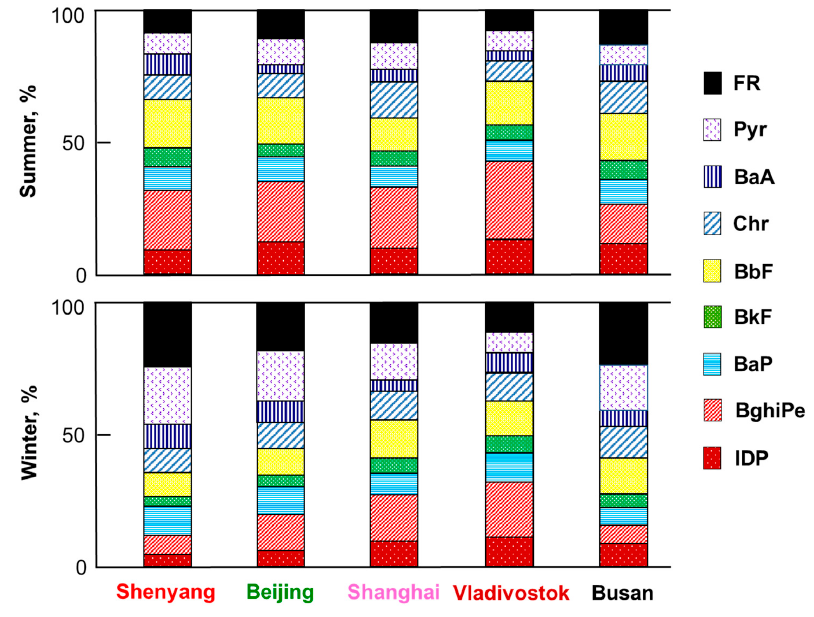
Figure 4. Composition of PAHs in 2013/2014.